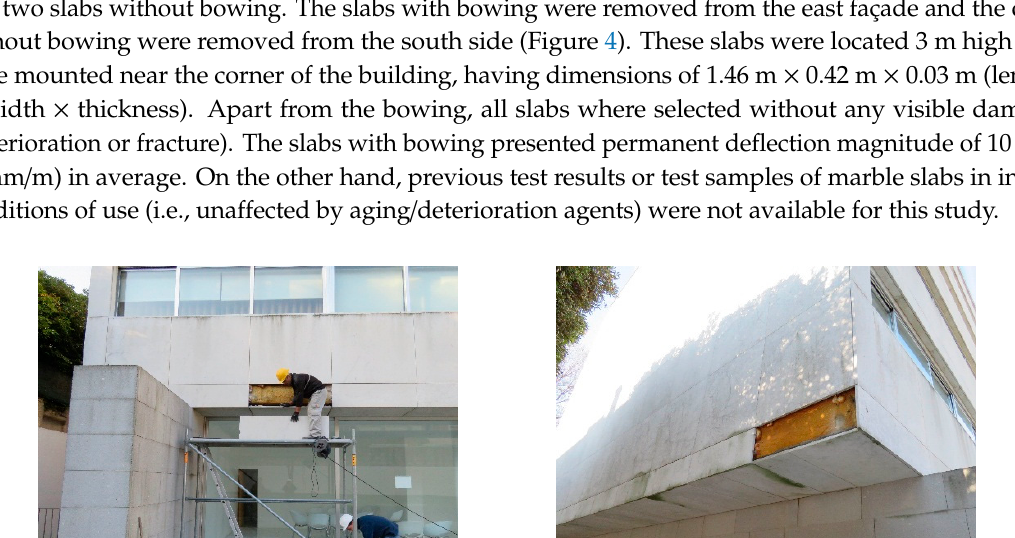
Figure 4. Examples of stone slabs removed from the building façade: ( a ) east side; ( b ) south side.